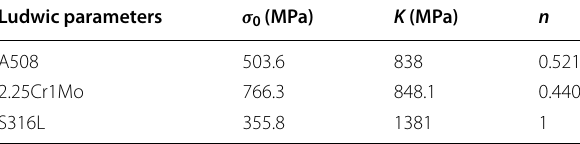
Table 2 Ludwic parameters of three materials fitted by experimental